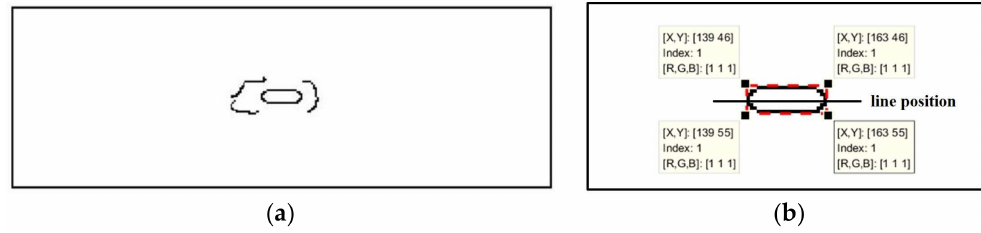
Figure 6. Edge detection results: ( a ) crack profile and ( b ) location of cracks and straight lines.